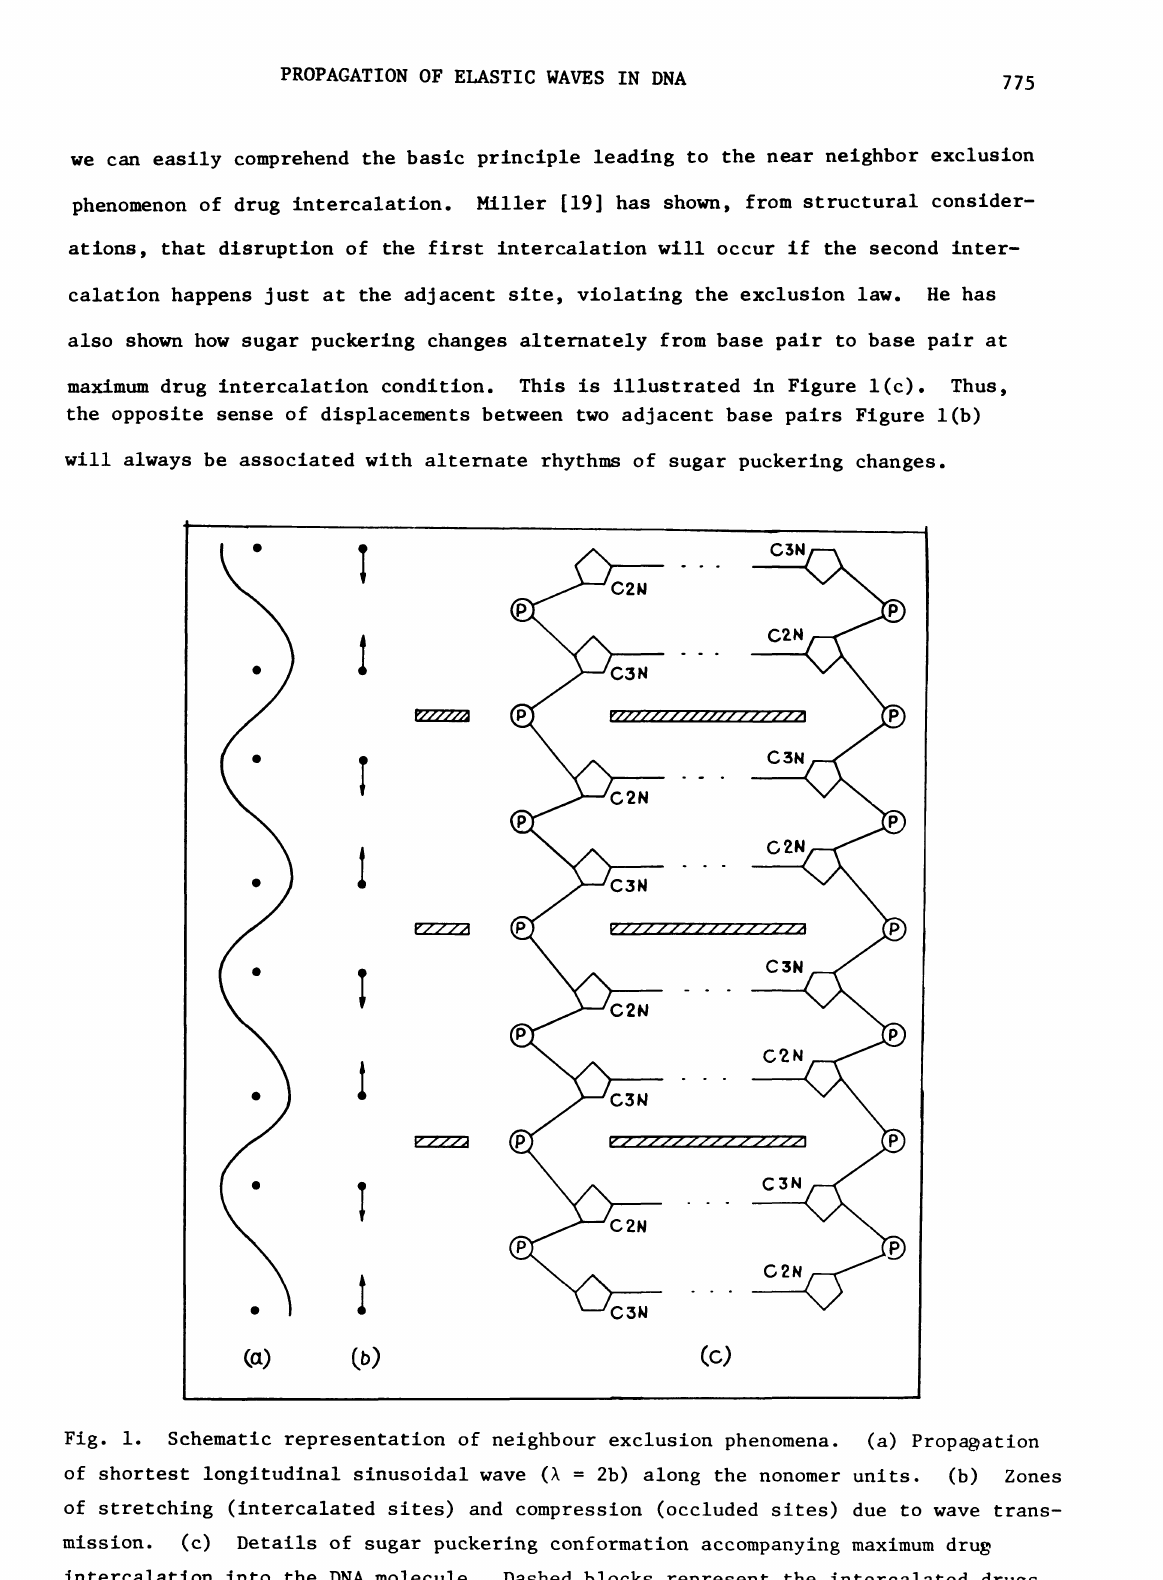
Fig. i. Schematic representation of neighbour exclusion phenomena. (a) Propagation of shortest longitudinal sinusoidal wave ( 2b) along the nonomer units. (b) Zones of stretching (intercalated sites) and compression (occluded sites) due to wave trans- mission. (c) Details of sugar puckering conformation accompanying maximum dru intercalation into the DNA molecule. Dashed blocks represent the intercalated drugs and C2N or C3N stands for C2’-endo or C3’-endo configuration of pentose